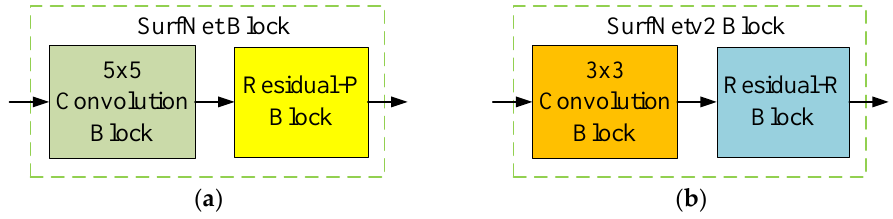
Figure 6. Comparison of ( a ) the original SurfNet block and ( b ) the proposed SurfNetv2 block.